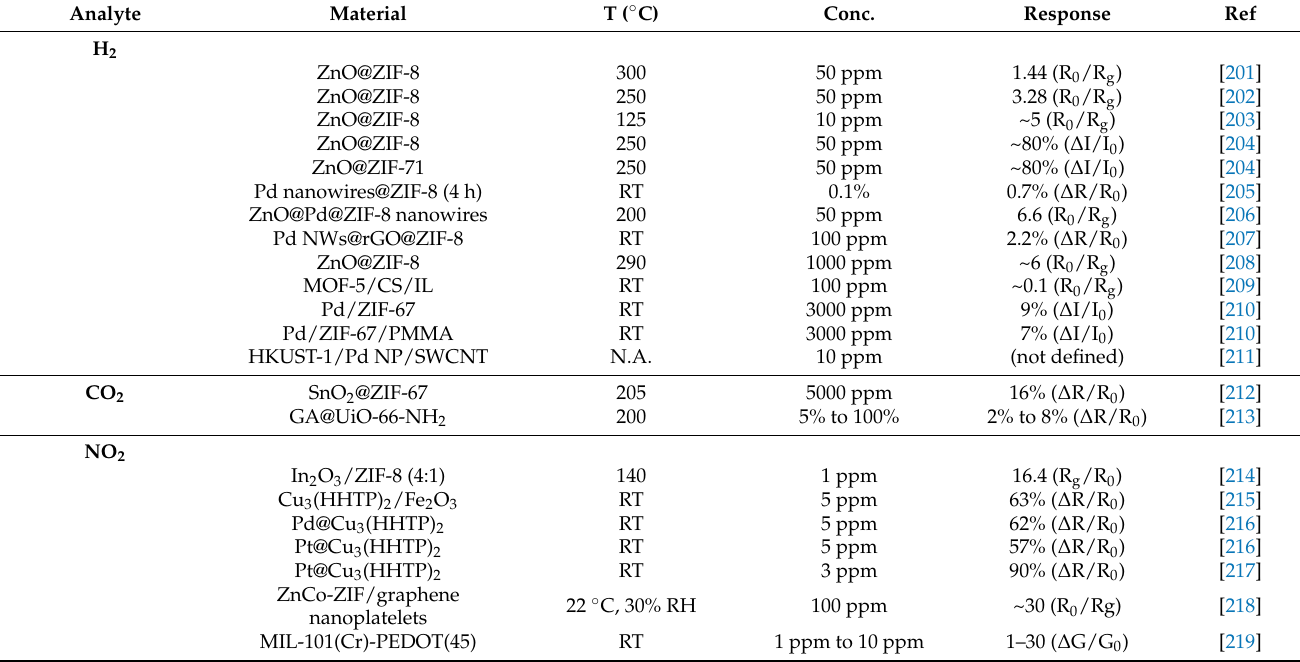
Table 3. Literature results regarding use of MOF-based composites as chemiresistive gas sensors. Response, as defined in the table, is mentioned when available for a specific value of the analyte concentrations and/or for a range of values. Unless stated otherwise, the letters R, I and G are used to indicate the electrical resistance, the current intensity and the conductance, while the suffix “0” and “g” refer to the values of one of such quantities measured in air (i.e., without an analyte) and in the presence of the gas analyte. ∆ R = |R g − R 0 |; ∆ I and ∆ G hence indicate the gas-induced change in resistance, current intensity and electrical conductance,